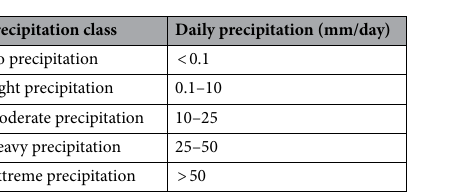
Figure 5. Spatial distributions of KGE ʹ _O, KGE ʹ _C, and ∆KGE ʹ for IMERG and ERA5-Land.